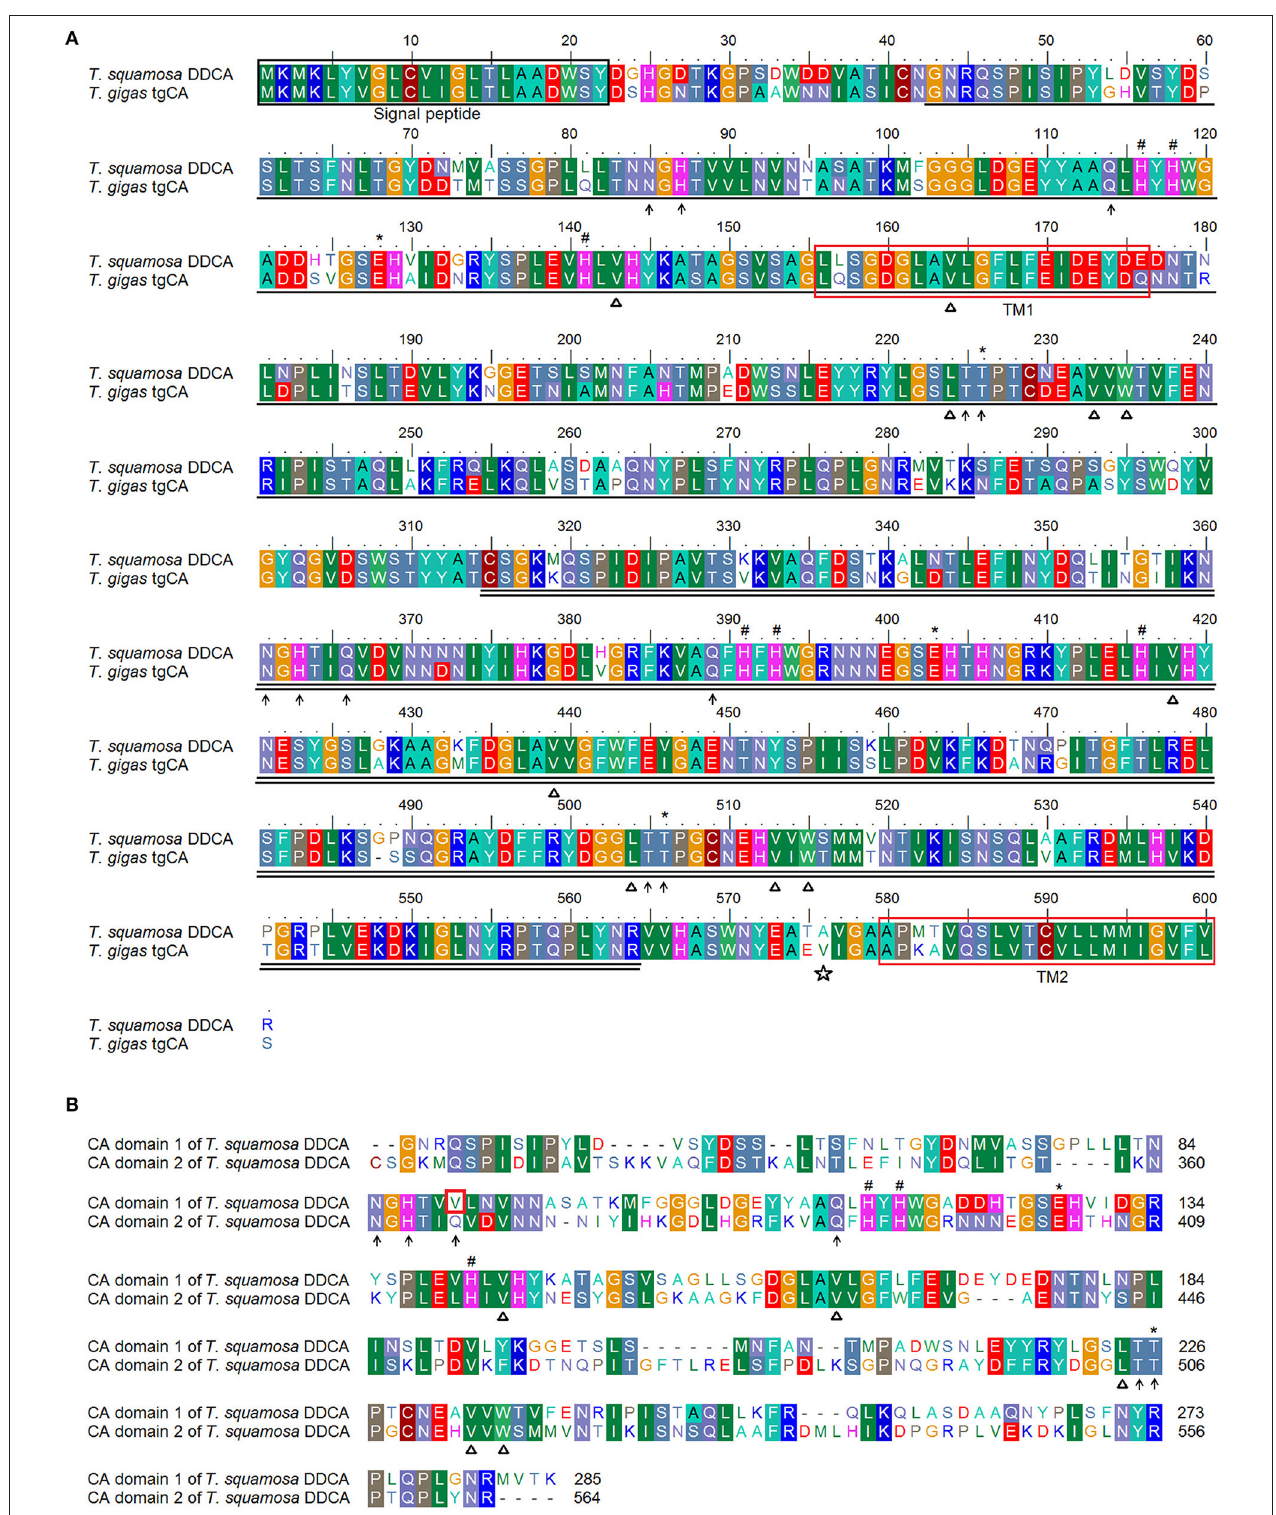
FIGURE 1 | Molecular characterization of the Dual Domain Carbonic Anhydrase (DDCA) of Tridacna squamosa . (A) An amino acid sequence alignment of the DDCA of T. squamosa and tgCA of T. gigas . (B) A comparison of the two CA domains of the DDCA of T. squamosa . The shaded residues indicate identical or highly similar